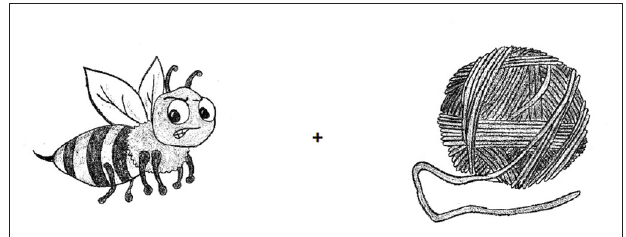
FIGURE 1 | A sample trial illustrating the presentation of the images, sting (left) and string (right) , and fixation cross.